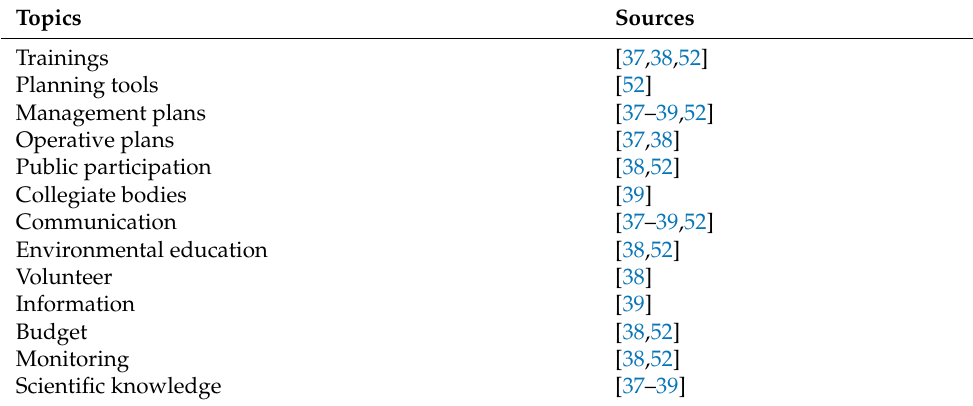
Table 2. Topics evaluated with indicators adapted from other